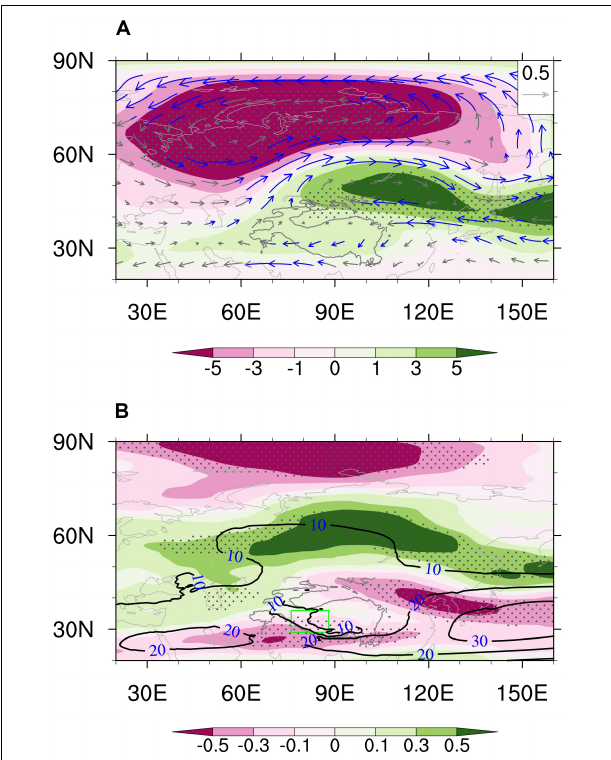
FIGURE 6 | Regression fields of (A) the winter geopotential height (shaded; units: m) and horizontal wind vector (units: m/s), and (B) zonal wind speed (shaded; units: m/s) at 500 hPa, against the BSICI. Blue arrows in A indicate vector values above the p = 0.1 confidence level. The black contours in B represent the climatology of the zonal wind speed with intensity larger than 10 m/s. The shaded values of the stippled areas exceed the p = 0.1 confidence level. The black box in B represents the MWTP region. The gray line over the region (25 ◦ –45 ◦ N, 60 ◦ –110 ◦ E) outlines the 2-km topography of the Tibetan Plateau.